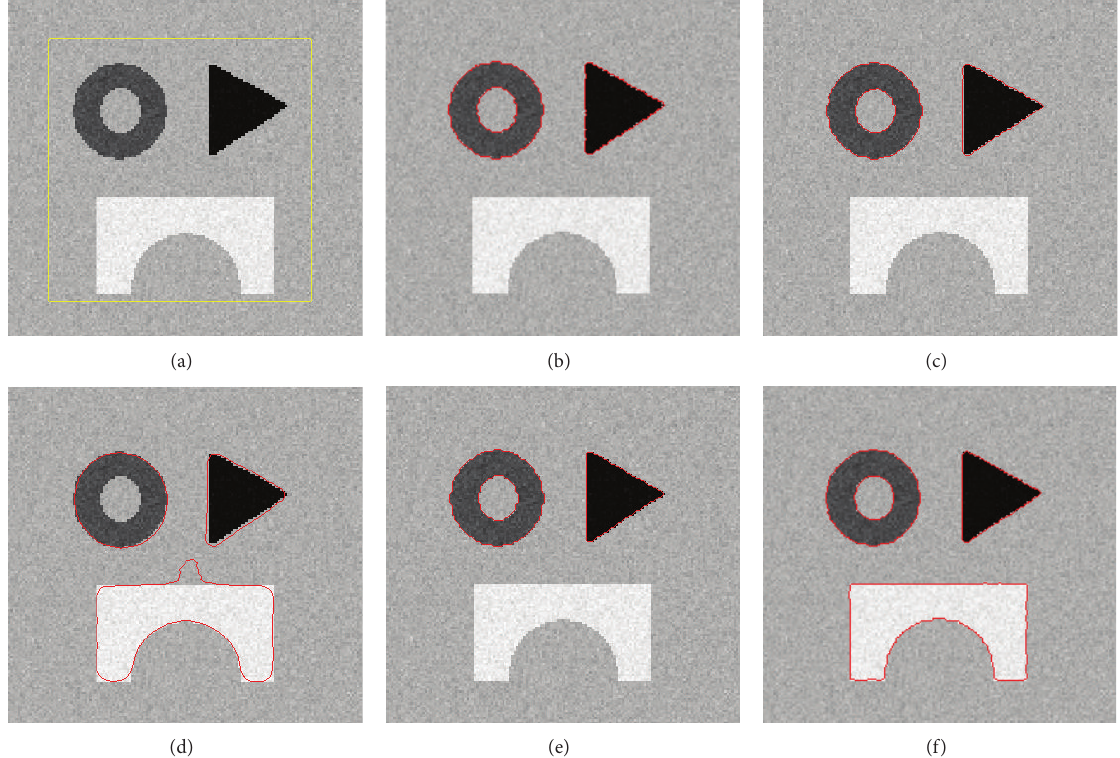
Figure 8: Segmentation results on the synthetic image corrupted by Gaussian noise: (a) the initial contour, (b) the CV model result, (c) the GACV model result, (d) the DRLSE model result, (e) the FAC model result, and (f) the LFAC model